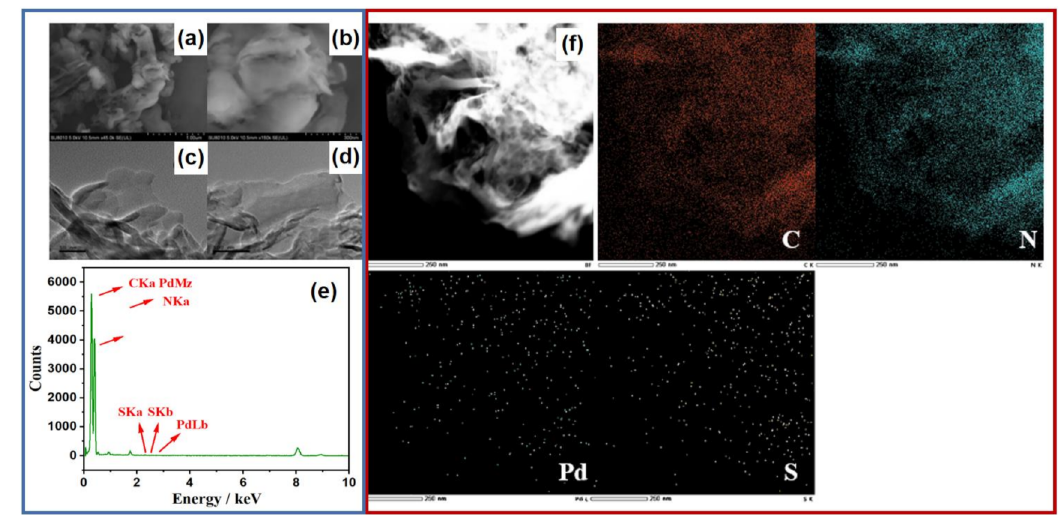
Figure 2. ( a , b ) SEM, ( c , d ) TEM, ( e ) EDX, and ( f ) element mapping images of g-C 3 N 4 /MOC- Q2 (0.7